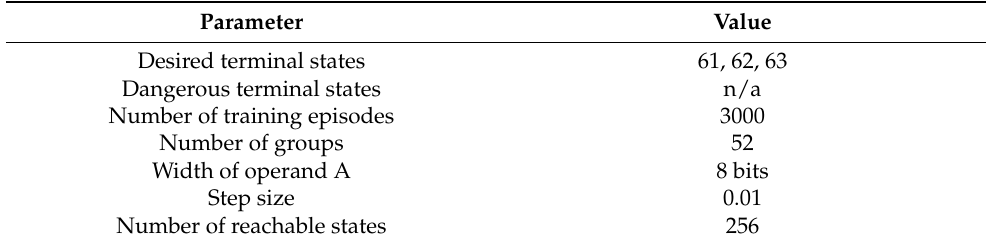
Figure 9. Vector of state values after training two agents using the third reward scheme. Two agents (represented by run_9 and run_10) are shown in the figure. It can be seen again that although the same training setup was used, they learned differently because they randomly selected different actions during the training process. Table 6. Configuration parameters are held constant during the evaluation of the effect of the discount factor value on the agent training quality.